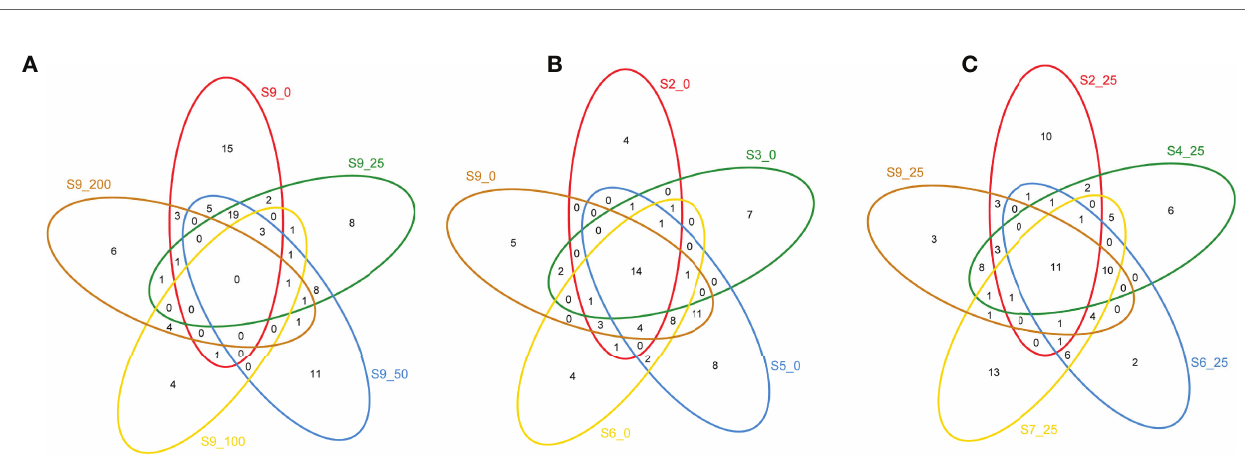
FIGURE 5 | Veen map analysis of dmdA gene diversity in spatial and vertical scale. (A) common OTUs in the vertical layers; (B) common OTUs in the surface water; (C) common OTUs in the 25-m water